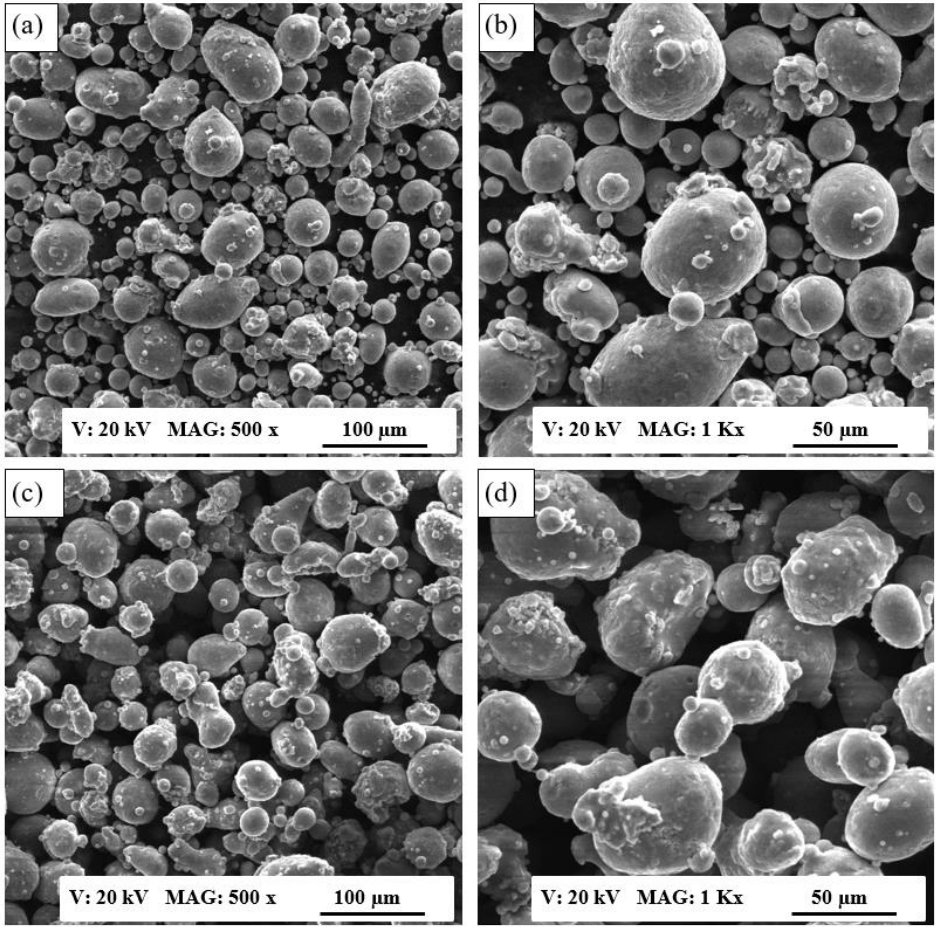
Figure 1. SEM observations of the powder morphology: ( a , b ) Al6061 powder, ( c , d ) AlSi10Mg